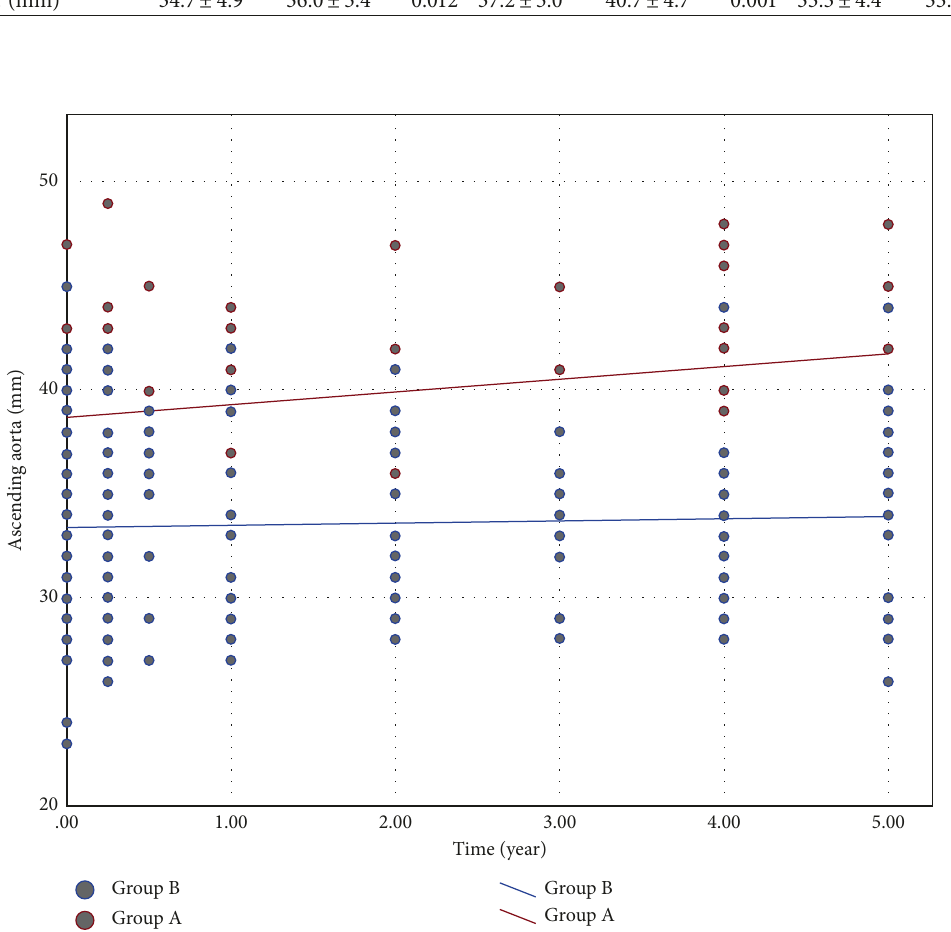
Figure 2: Dot plot depicting changes in the ascending aorta over five years after AVR in individual patients in group A (red dots) and group B (blue dots). Red line indicates the overall enlargement rate of the ascending aorta in group A calculated according to a linear mixed model. Blue line indicates the overall enlargement rate of the ascending aorta in group B calculated according to a linear mixed model. Table 3: Ascending aorta diameter changes after AVR using univariable linear mixed